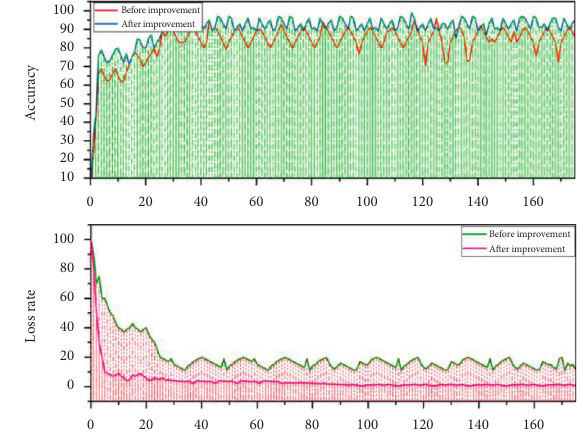
Figure 4: Model loss value and accuracy curve.